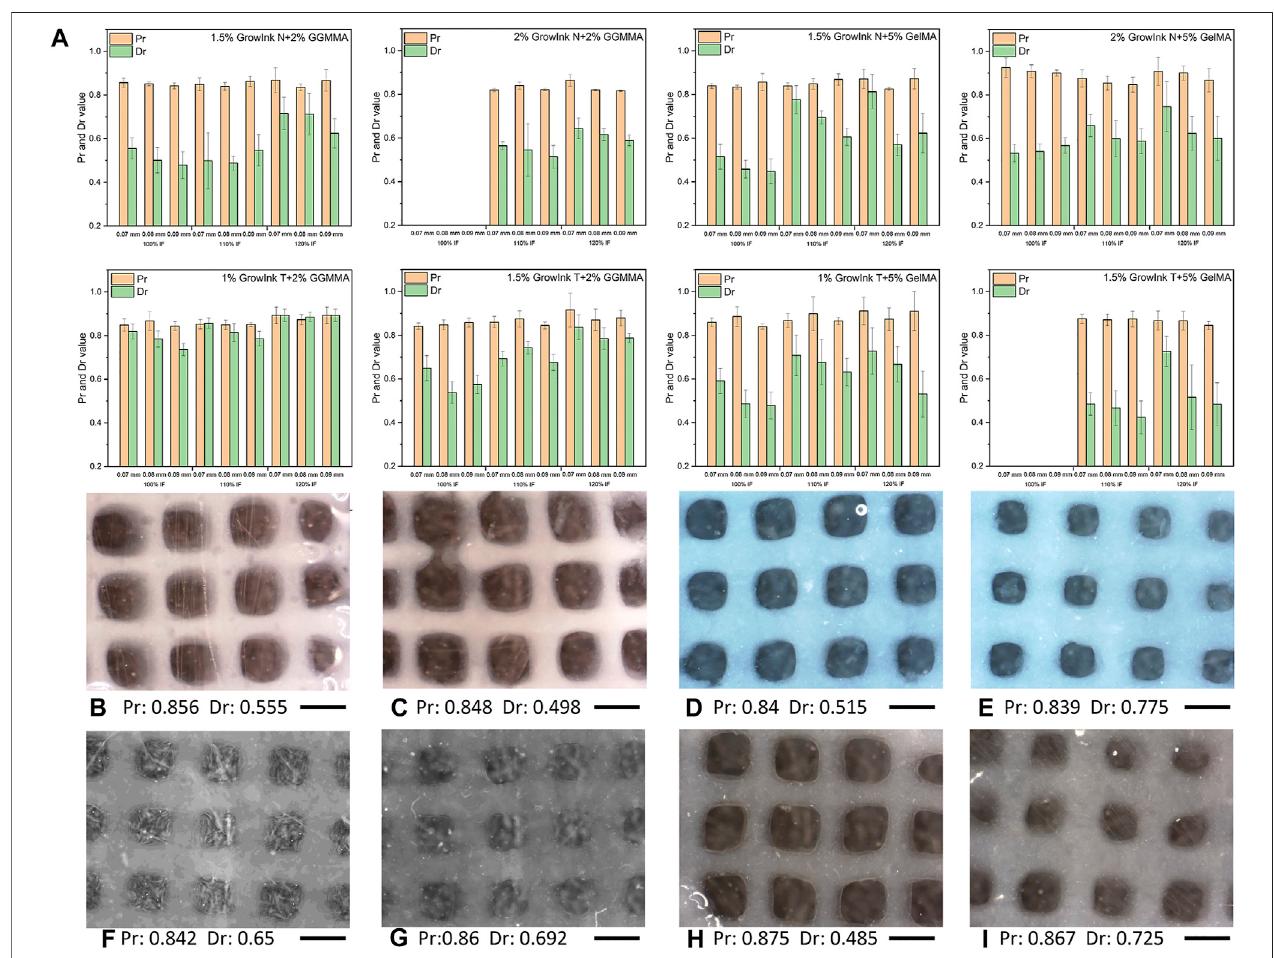
FIGURE 6 | (A) Pr and Dr values and (B – I) optical microscope images of the cross-hatch scaffold printed with formulated inks under different printing parameters: (BandC) printedwith1.5%GrowInk-N+2%GGMMA-PBSwithalayerheightof0.07 mmandaninput fl owrateof100and110%,respectively, (DandE) printedwith 1.5% GrowInk-N+5% GelMA-PBS with a layer height of 0.07 mm and an input fl ow rate of 100 and 110%, respectively, (F and G) printed with 1.5% GrowInk-T + 2% GGMMA-PBSwithalayerheightof0.07 mmandaninput fl owrateof100and110%,respectively, (HandI) printedwith1.5%GrowInk-T+5%GelMA-PBSwitha layer height of 0.07 mm and an input fl ow rate of 110 and 120%, respectively. Scale bar: 1 mm)